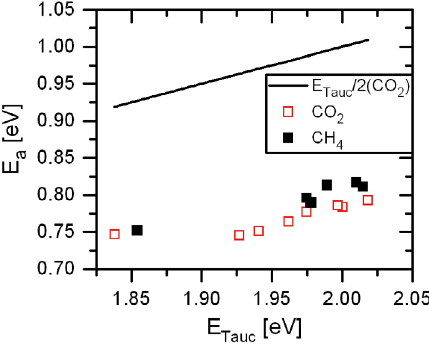
Fig. 10. Activation energy of amorphous silicon alloy single layers produced with CO 2 or CH 4 against Tauc bandgap at room